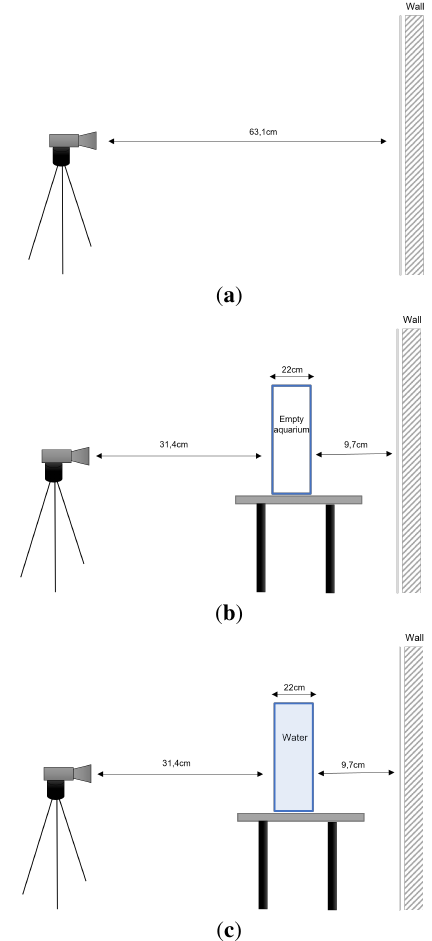
Figure 2. Experimental setup for the three tests: (a) Wall test; (b) Empty test; (c) Water full